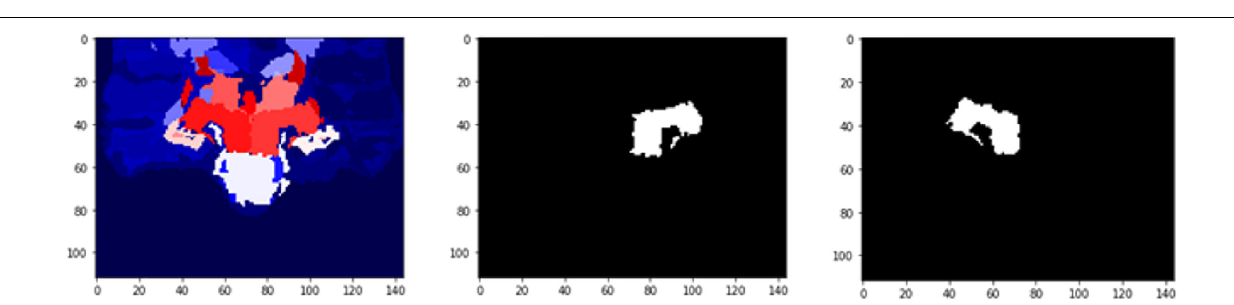
FIGURE 12 | 2D scan from the output volume of subject OAS30052_MR_d0693. We have chosen the Right Thalamus Proper and Left Ventral DC of the brain structures equal to 23 and 24 intensity values. The 2D scans are from different axial slices of the same subject compared with the 2D scans in Figure 11 .